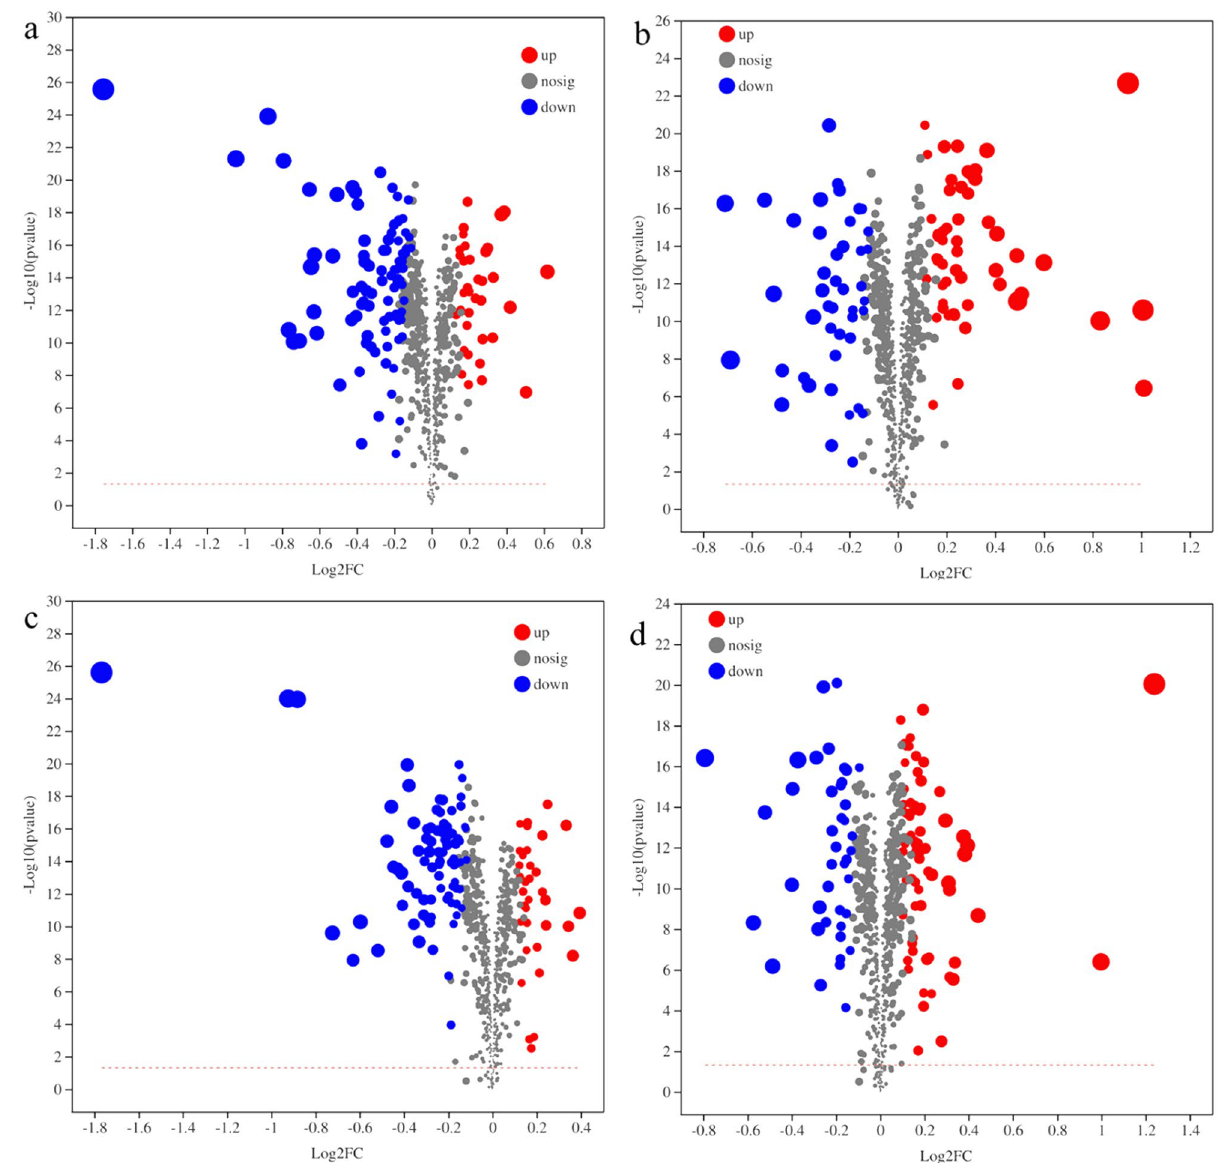
Figure 5. Volcano maps of differential metabolites in four pairwise comparisons: ( a ) WL440_2 vs WL440_1; ( b ) ZD_2 vs ZD_1; ( c ) ZD_1 vs WL440_1; ( d ) ZD_2 vs WL440_2. Note : Volcano map is used to show the relative content difference of metabolites between the two groups of samples and the statistical significance of the difference. Each point in the volcano map represents a metabolite, where red points represent up-regulated differential metabolites, gray points for non-significantly different metabolites, and green points for down- regulated differential metabolites. The abscissa represents the logarithmic value (log 2 FC) of the multiple difference of the relative content of a metabolite in the two groups of samples. The larger the absolute value of the abscissa, the greater the relative content difference of the metabolite between the two groups of samples. The ordinate represents the VIP value, and the larger the ordinate value, the more significant difference is and the more reliable the differential metabolites obtained by